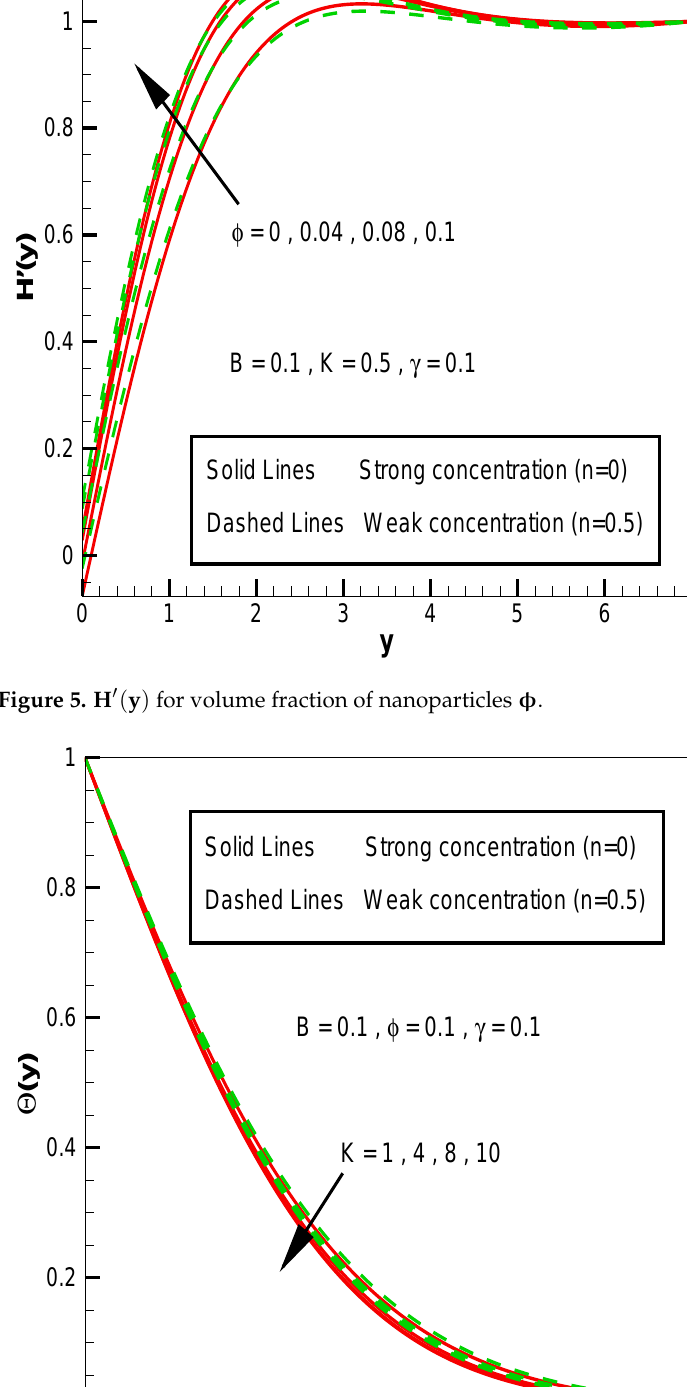
Figure 4. 𝐇 (cid:4593) (𝐲) for material parameter K.